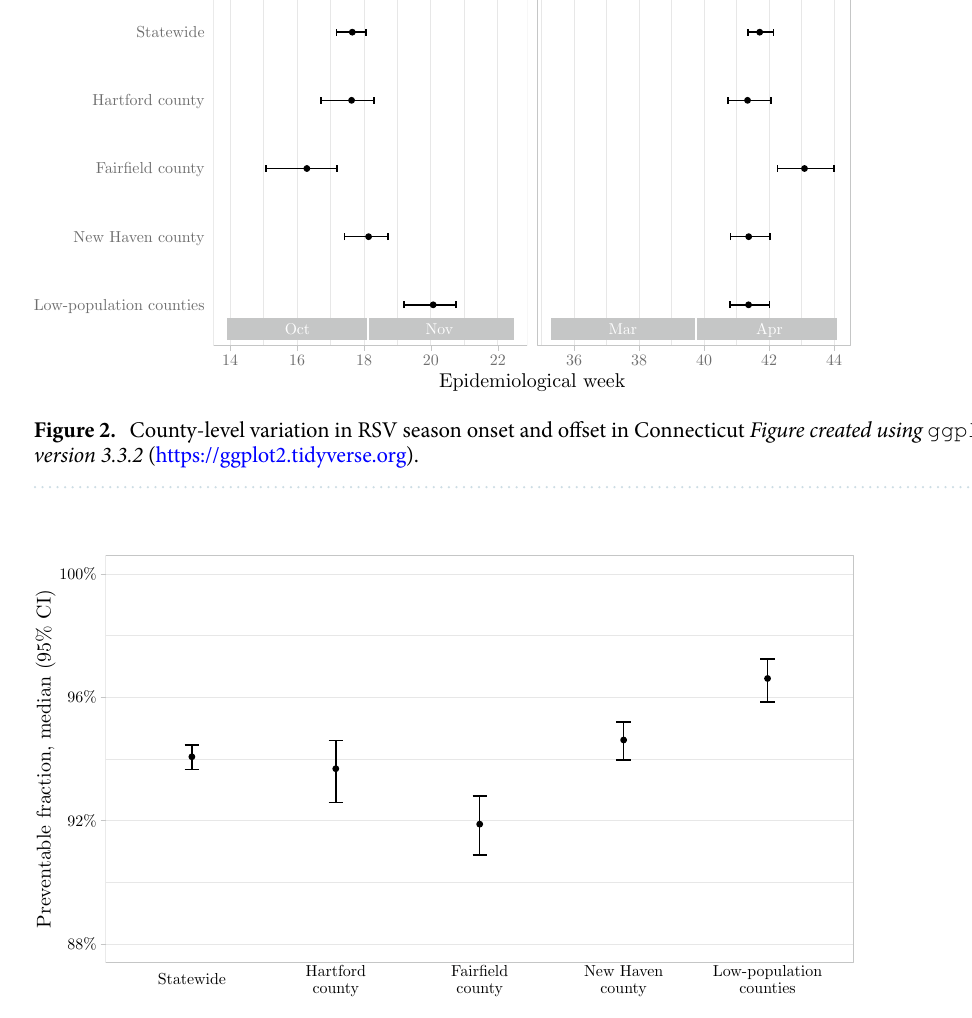
Figure 3. County-level variation in the preventable fraction of RSV hospitalizations according to AAP guidelines. The percentage of RSV hospitalizations occurring while protection by palivizumab—administered per the AAP guidelines—is active is plotted for each geographic region in Connecticut. Figure created using ggplot2 version 3.3.2 (https:// ggplo t2. tidyv erse.